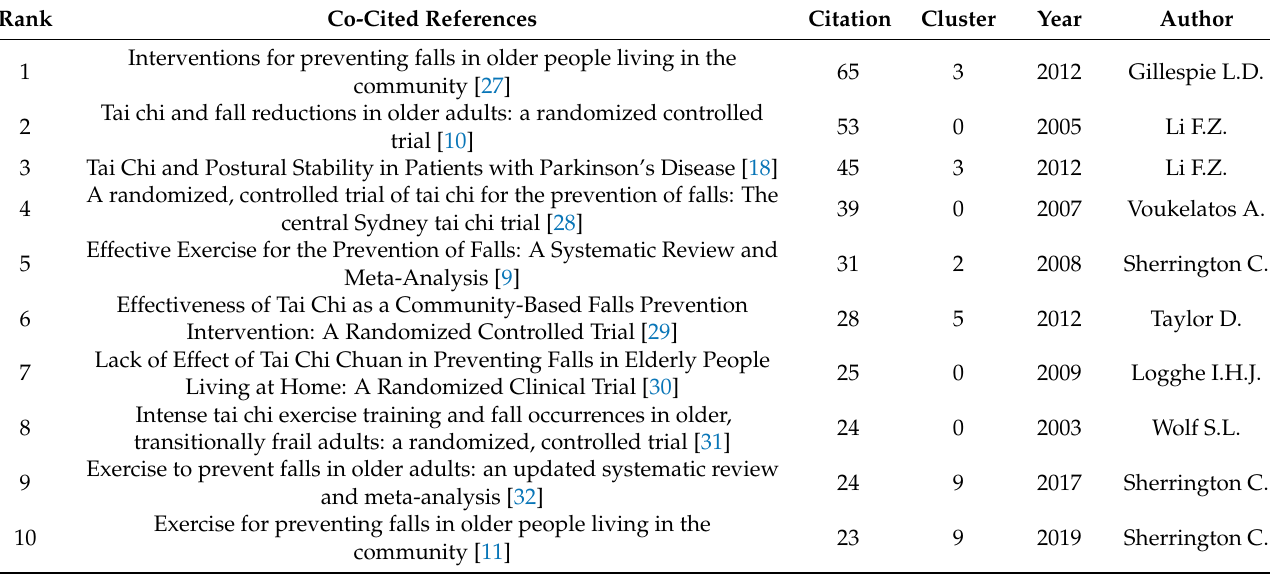
Table 1. Top ten co-cited references with high citation